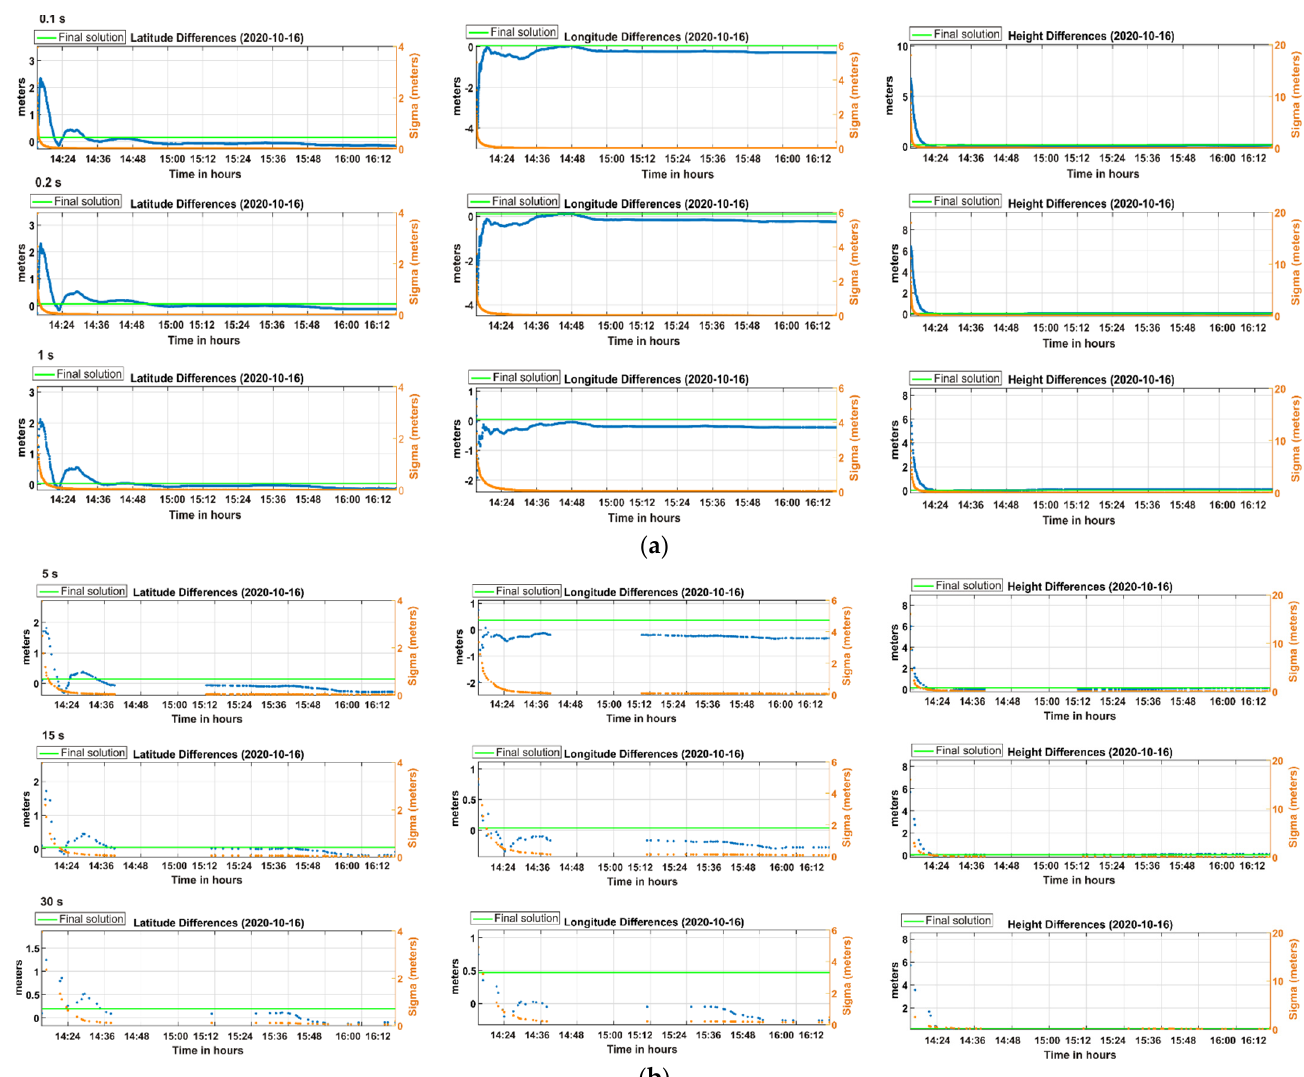
Figure 14. Low-cost GNSS static mode obtained by processing with CSRS-PPP: ( a ) sampling rate: 0.1, 0.2 and 1 s; ( b ) sampling rate: 5, 15 and 30 s.